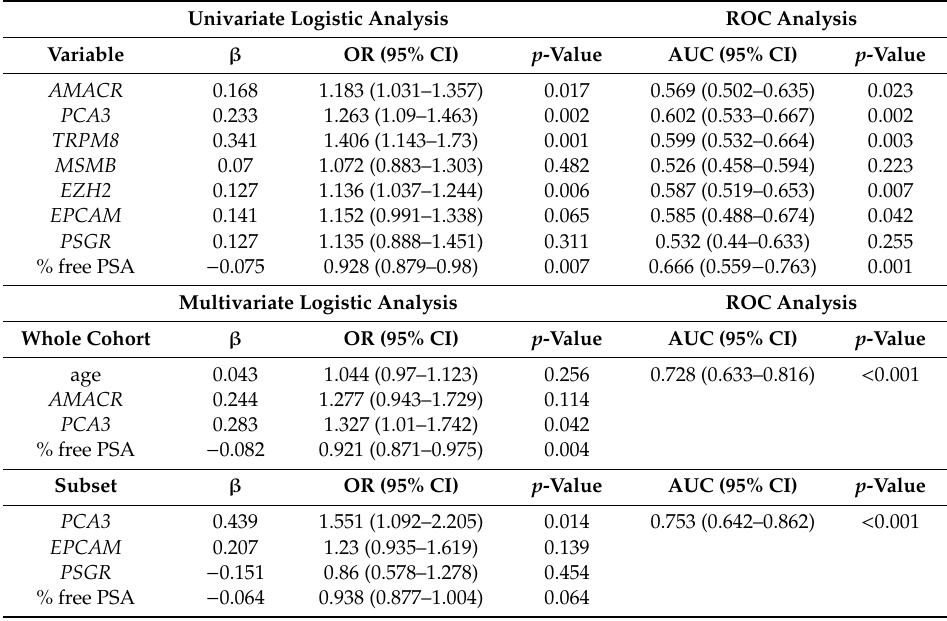
Table 3. Univariate and multivariate analysis.